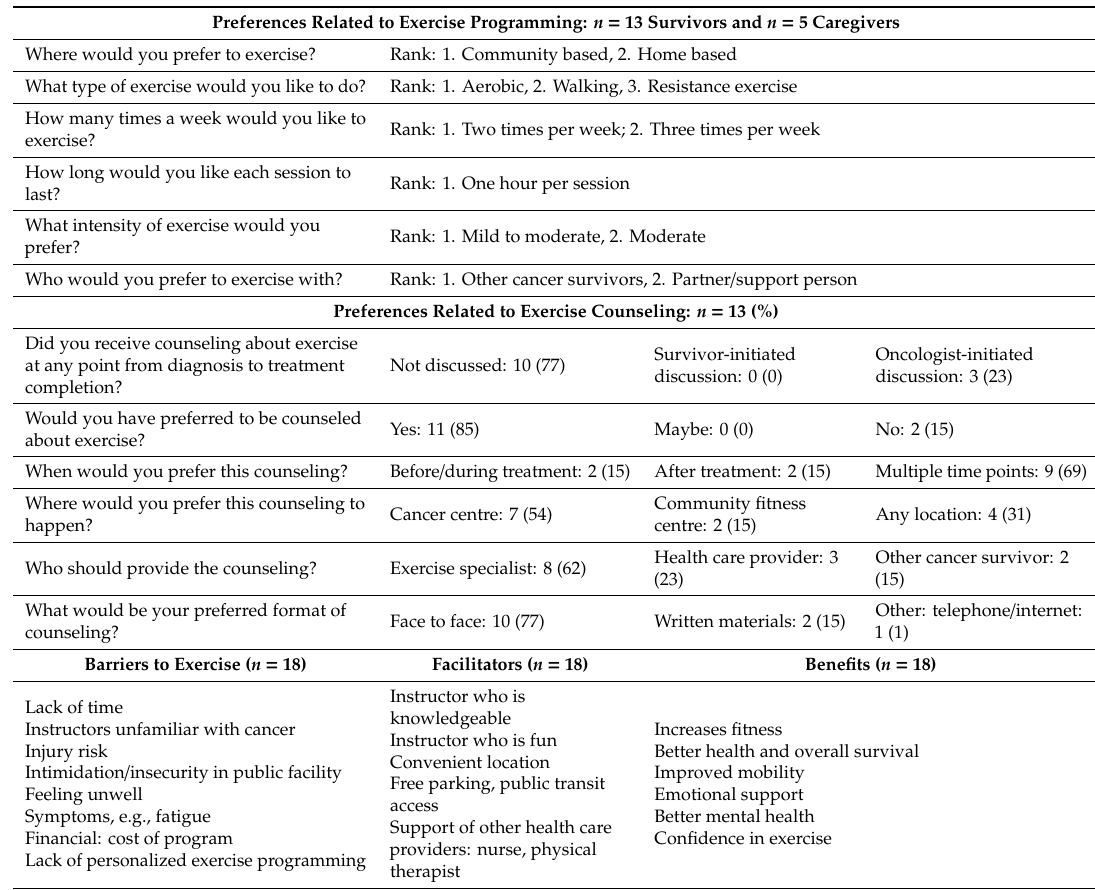
Table 2. Pre-ACE exercise preferences, barriers and facilitators /